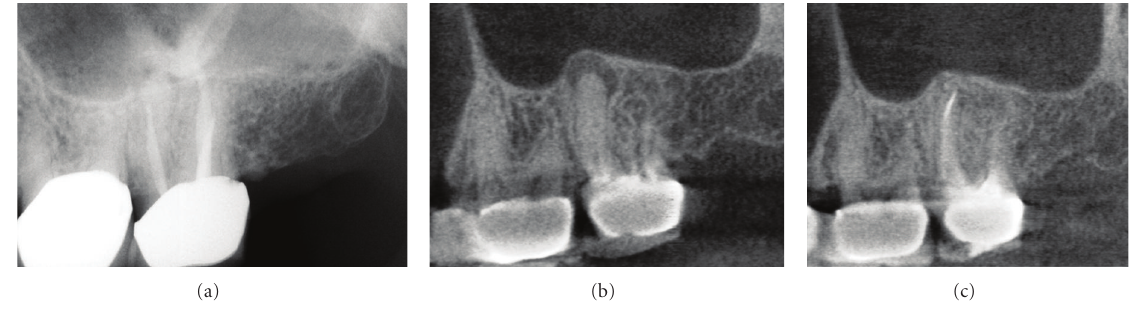
Figure 10: A periapical radiograph of the maxillary left first molar (a) shows an area of low density surrounding the mesial root with incomplete endodontic treatment. A contemporaneous CBCT parasagittal image (b) shows a chronic periradicular osteoperiostitis, or “halo lesion,” where the apical periodontitis has caused displacement of the periosteum but did not penetrate the antral floor. Three months after retreatment, CBCT imaging (c) demonstrates complete apical resolution.